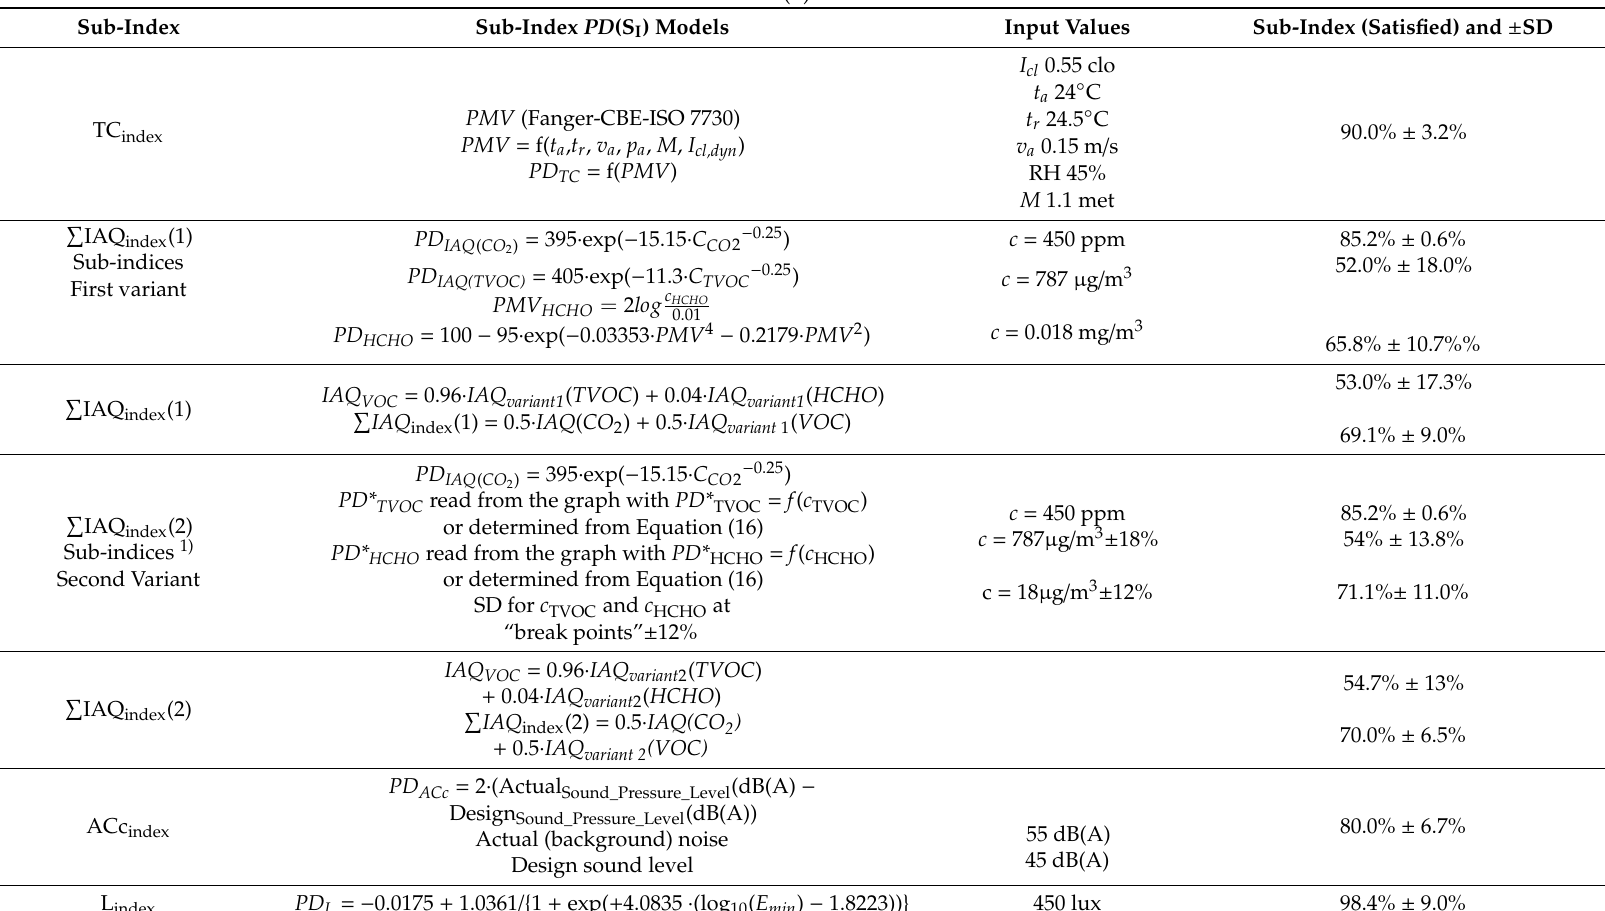
Table 8. ( a ) Physical parameters (Footnote 1 in Table 5) and IEQ results calculated from Equation (9) with measurements for the case study building (47th floor; open space) a few days after completion of the finishing works. ( b ) Measured pollutant concentrations c and standard deviations SD( c